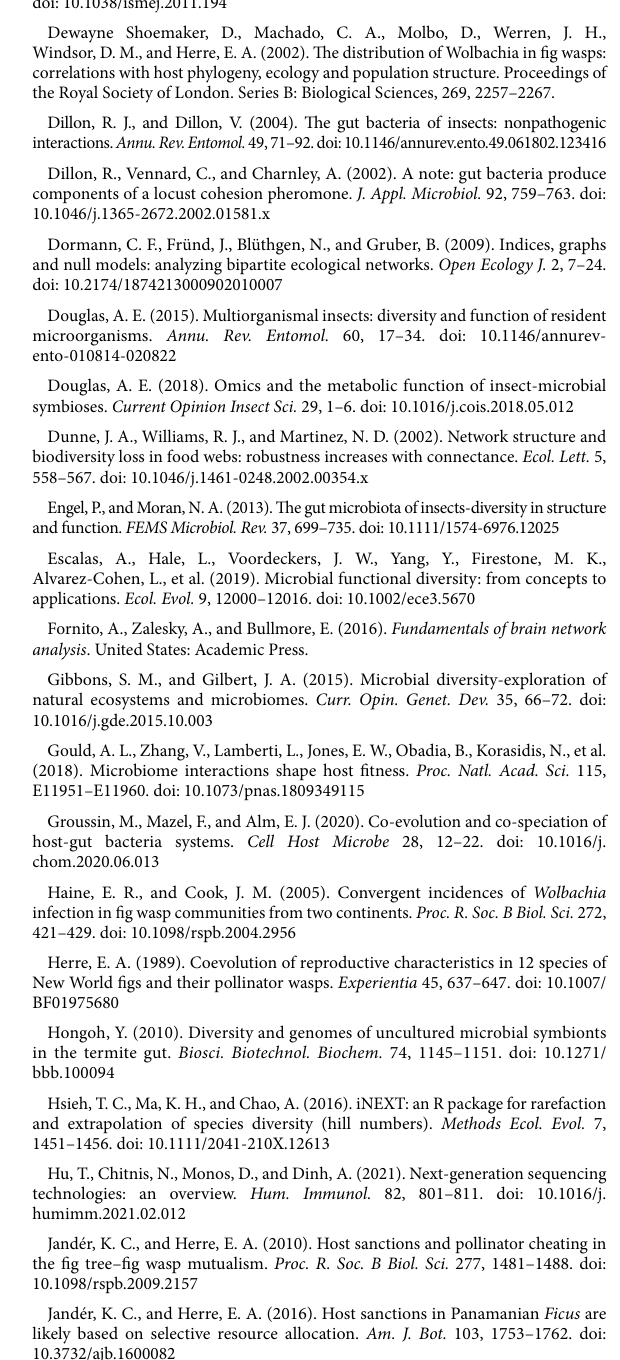
link line reflects the absolute value of correlation coefficient and the color of link line represents the positive (gray) and negative (red) correlation coefficient. Fa_C represents the cheater of F. altissima ; Fa_P represents the pollinator of F. altissima ; Fm_C represents the cheater of F. microcarpa ; Fm_P represents the pollinator of F. microcarpa .